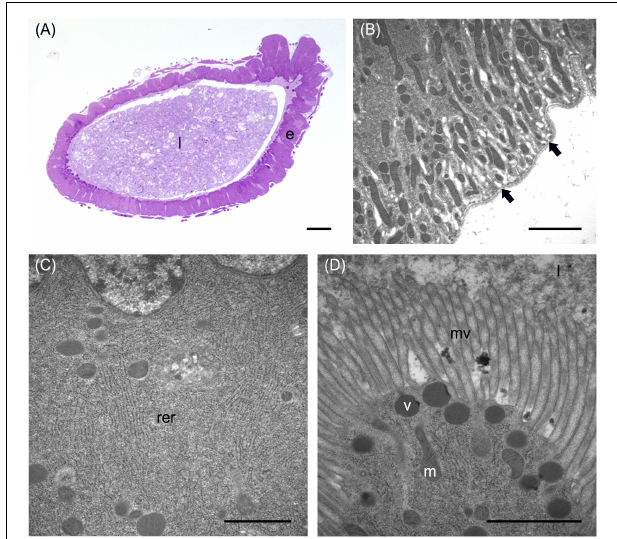
FIGURE 3 | Morphological organization of the AMG. (A) cross-section of AMG. (B) Wide basal infolding (arrows) in columnar cells. (C) Rough endoplasmic reticulum (rer) in the cytoplasm of columnar cells. (D) Electron-dense vesicles (v) in the apical part of columnar cells, under the microvilli (mv). e: epithelium; l: lumen; m: mitochondria. Bars: 100 µ m (A) , 2 µ m (B) , 1 µ m (C,D)